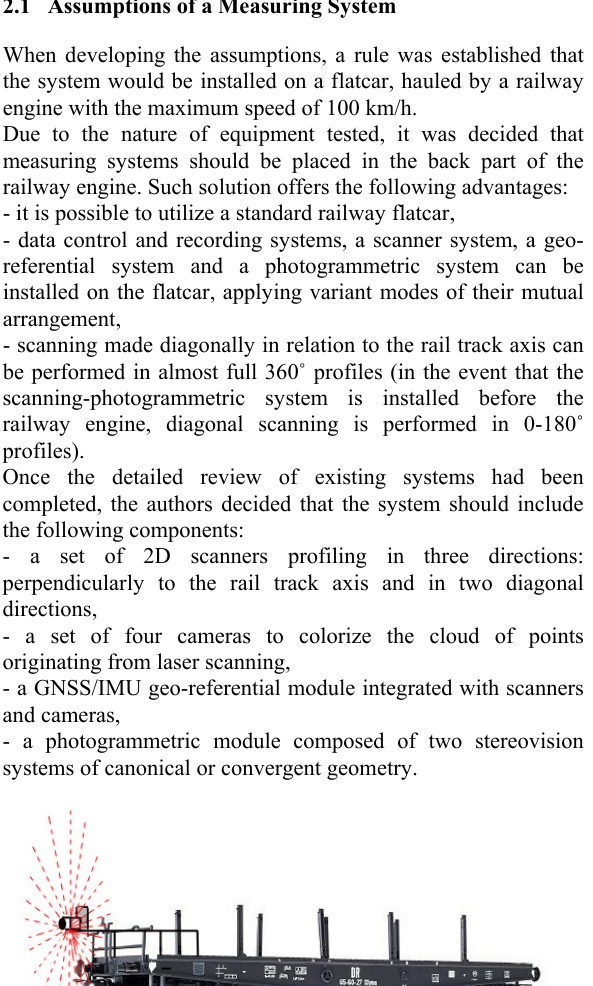
Figure 3. System I – Profiler 9000 scanner during